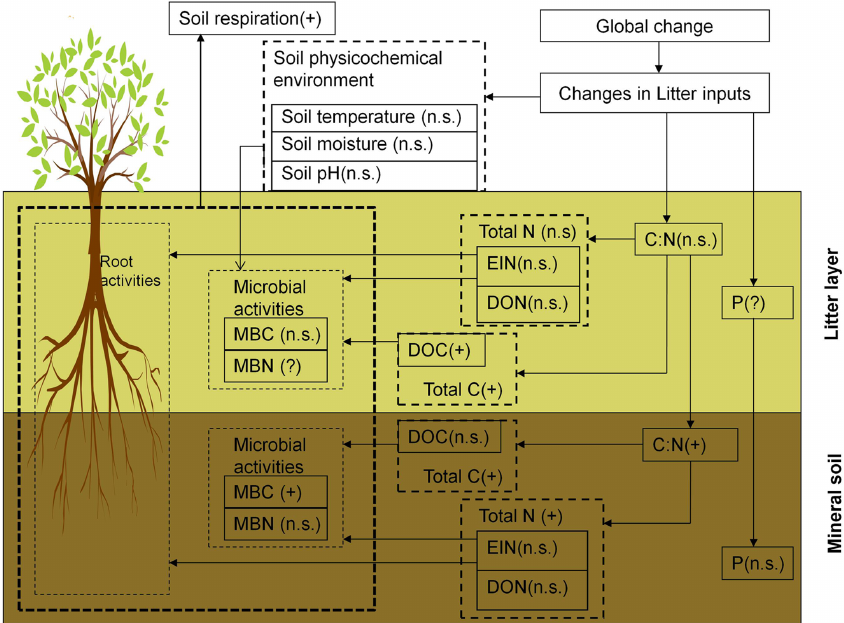
Fig. 2. The responses of soil carbon and nutrient cycling to changes in litter inputs, where MBC is microbial biomass carbon, MBN microbial biomass nitrogen, DOC dissolved organic carbon, DON dissolved organic nitrogen, EIN extractable inorganic nitrogen and P is extractable phosphorus. The relationship between the response ratio of each parameter and the quantity of litter inputs is shown in parentheses. “ + ” indicates a significant positive linear correlation; “ − ” indicates a significant negative linear correlation; n.s. is non-significant; “?” indicates an unknown relationship because of data